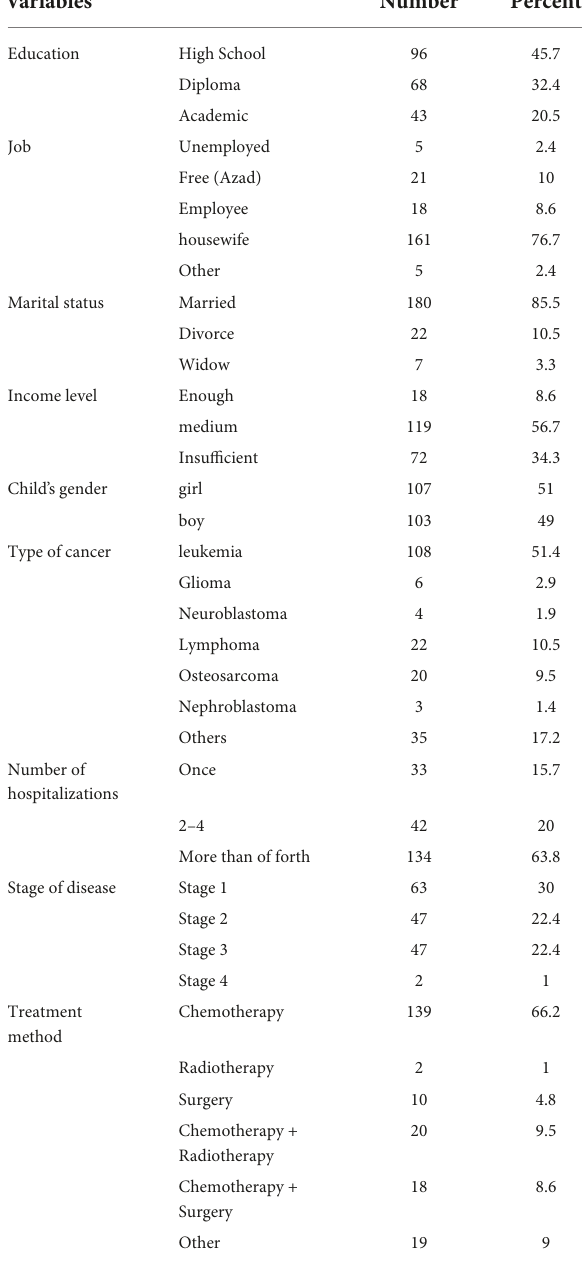
TABLE 1 Demographic and clinical variables of mothers with children with cancer. Variables